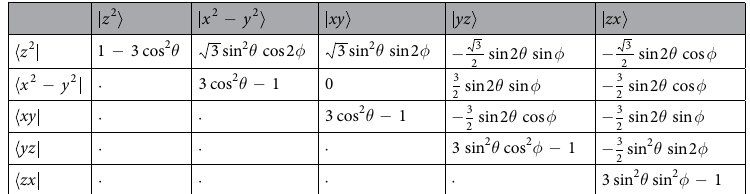
→ anion ⋅ Ψ ˆ f f H n / for five d orbital states. θ and φ are the polar and a